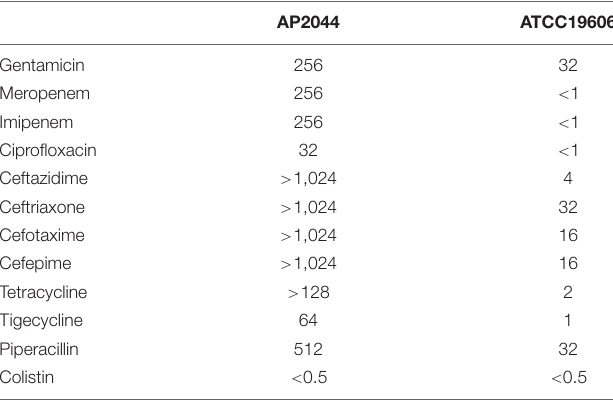
TABLE 1 | MICs (mg/L) of common antibiotics in AP2044 and ATCC19606.